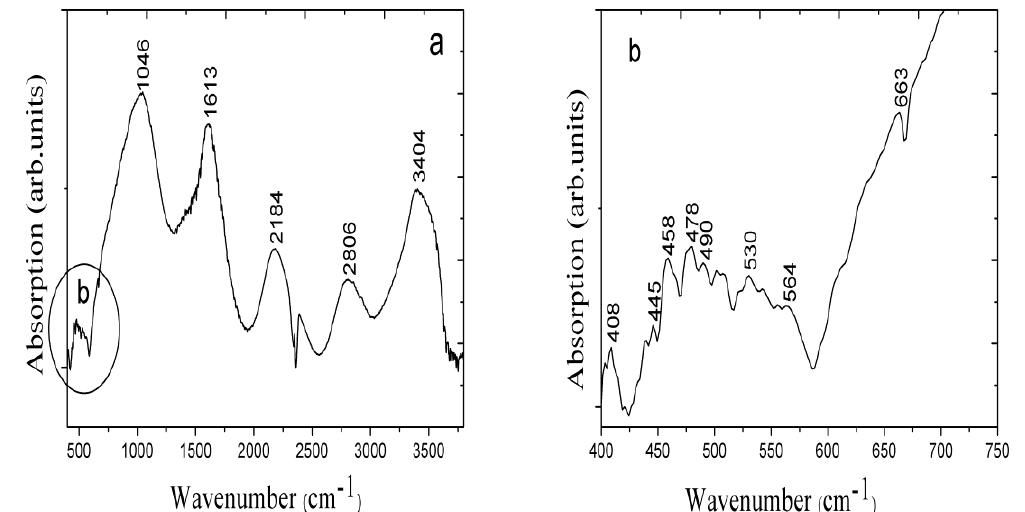
Figure 5. The FTIR spectrum of the ZnO nanorods grown with the seed solution of 70 mg of ZnO nanoparticles present in the chitosan solution at different frequency ranges ( a ) 400–4000 cm −1 ; and ( b ) 400–750 cm −1